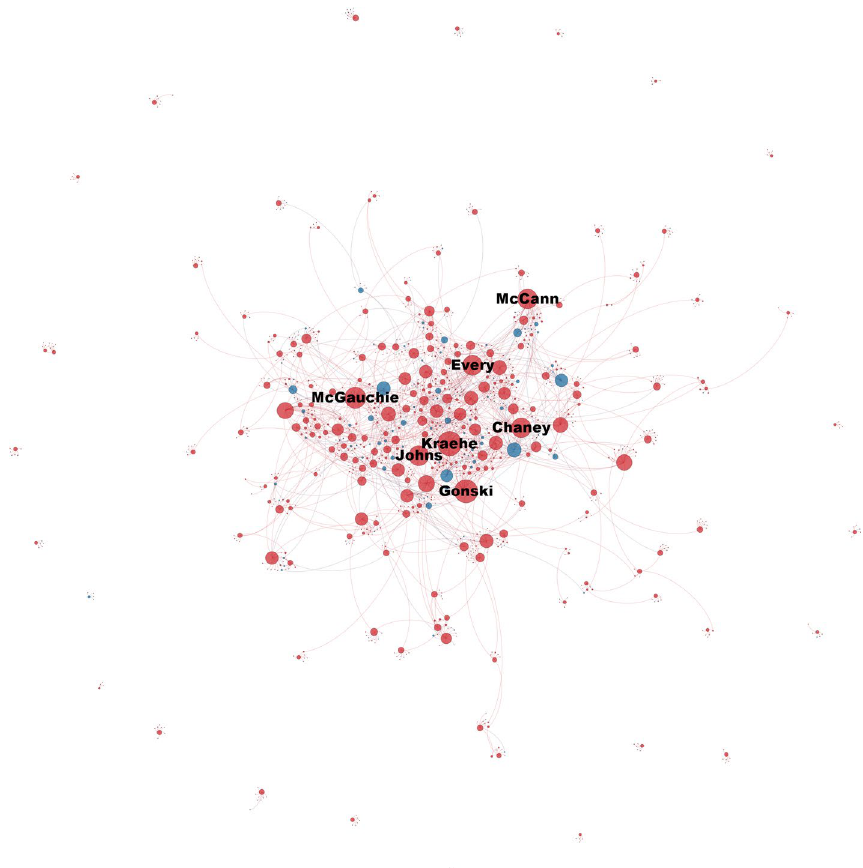
Fig. 3 Network Graph: Node Degree Centrality (2015) Network data visualizations use the Gephi OpenOrd, no overlap layout algorithm. Nodes are scaled based on the value of the corresponding metric (degree or betweenness centrality). The higher the centrality value, the larger the node. Clockwise edges connect board Chairs to board directors (the Chair is the source for each edge and the director is the target). Red nodes represent men, blue nodes represent